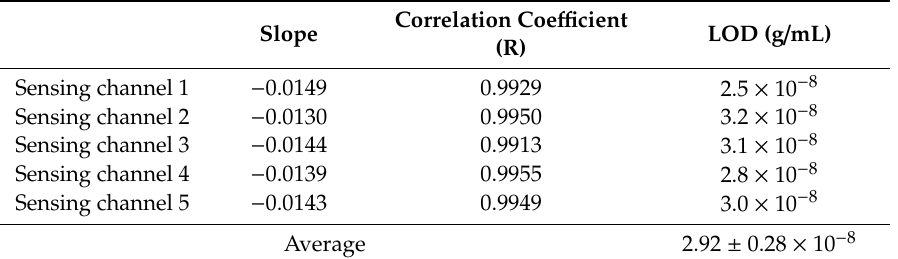
Table 2. Performance of the multi-microchannel FOPPR sensor system for detection of streptavidin / biotin binding.